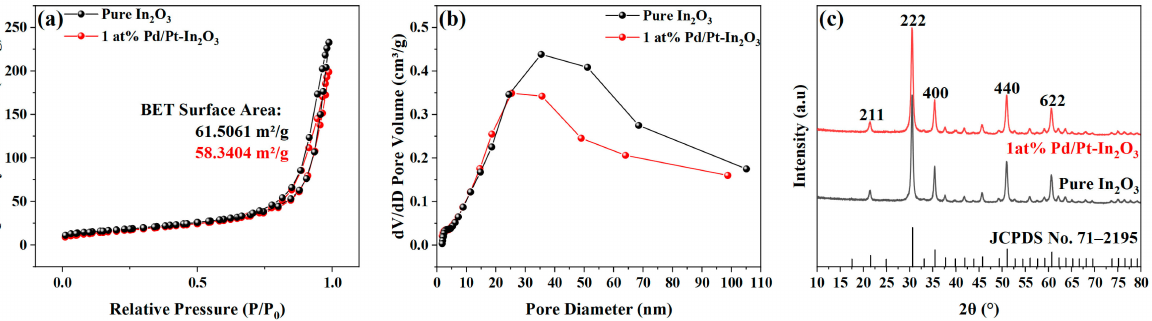
Figure 3. ( a ) Nitrogen adsorption − desorption isotherms of pure In 2 O 3 and 1 at% Pd/Pt-In 2 O 3 . ( b ) Corresponding pore size distributions of pure In 2 O 3 and 1 at% Pd/Pt-In 2 O 3 . ( c ) XRD image of pure In 2 O 3 and 1 at% Pd/Pt-In 2 O 3 .